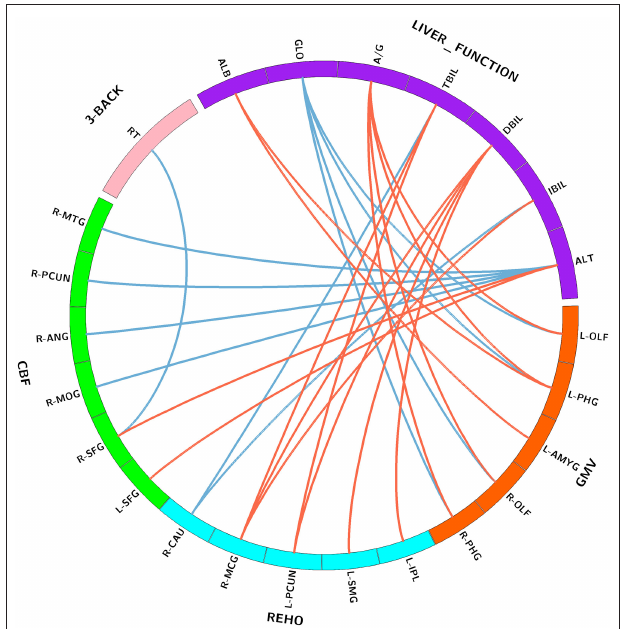
FIGURE 2 | Correlations between serum liver function markers, brain imaging parameters, and working memory performance. Purple block represents serum liver function markers; orange block represents GMV; blue block represents ReHo; green block represents CBF; and pink block represents 3-back task performance. Red lines indicate positive correlations, and blue lines indicate negative correlations. Abbreviations: GMV, gray matter volume; ReHo, regional homogeneity; CBF, cerebral blood flow; ALB, albumin; GLO, globulin; A/G, albumin/globulin; TBIL, total bilirubin; DBIL, direct bilirubin; IBIL, indirect bilirubin; ALT, alanine transaminase; OLF, olfactory cortex; PHG, parahippocampal; AMYG, amygdala; IPL, inferior parietal lobule; SMG, supramarginal gyrus; PCUN, precuneus; MCG, middle cingulate gyrus; CAU, caudate nucleus; SFG, superior frontal gyrus; MOG, middle occipital gyrus; ANG, angular gyrus; MTG, middle temporal gyrus; RT, reaction time; L, left; R, right.